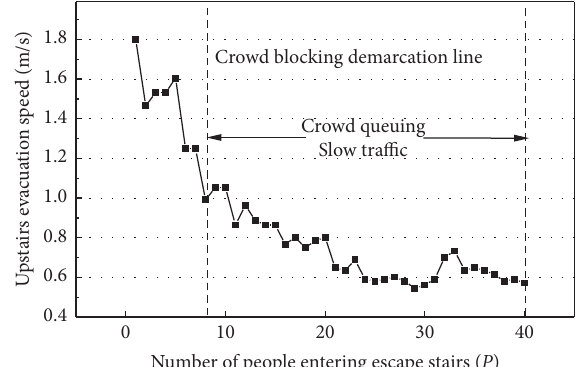
Figure 8: Curve of personnel upstairs speed.